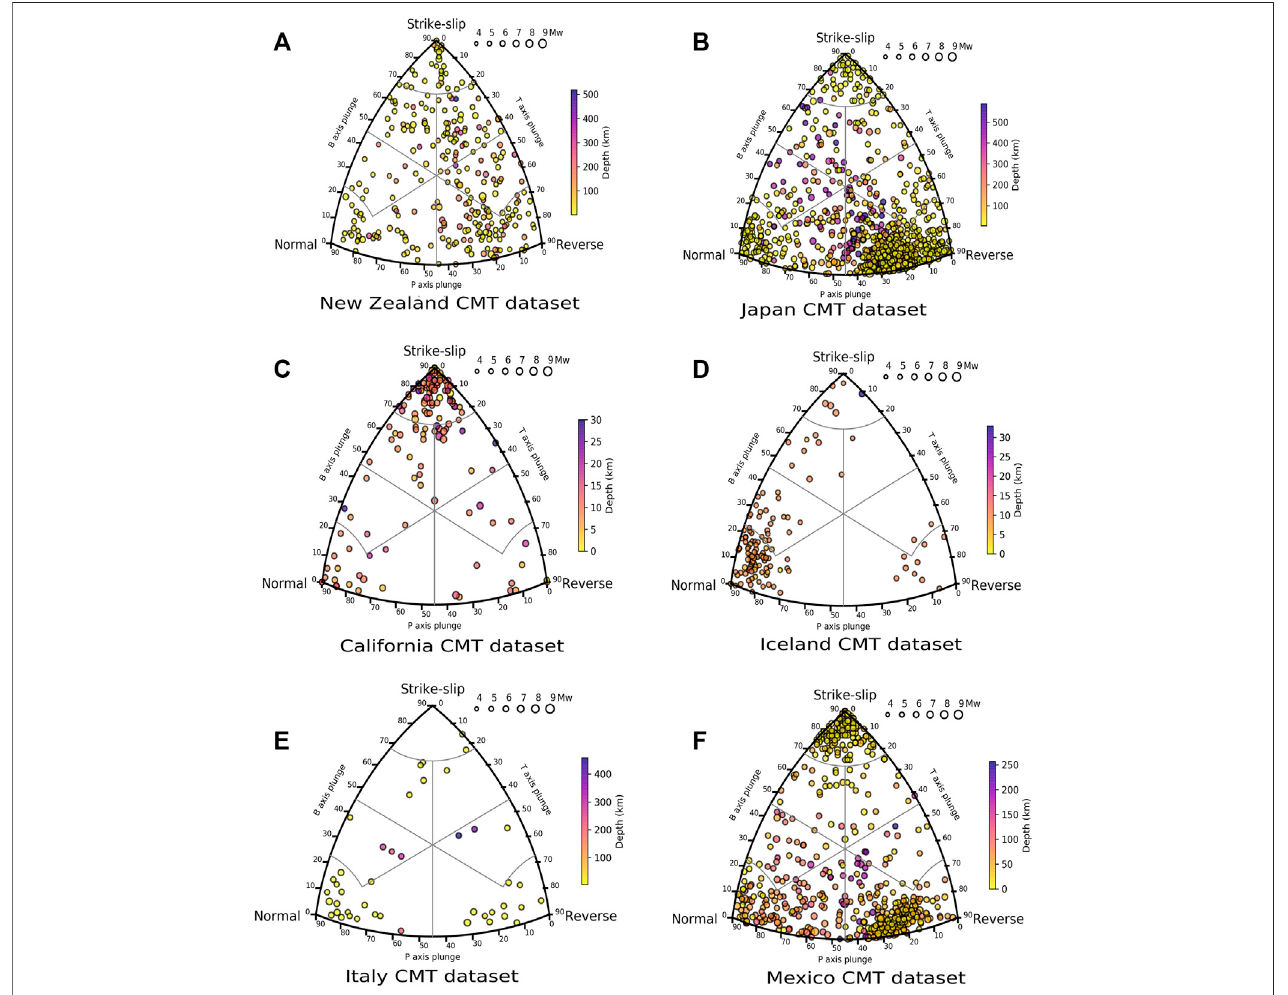
FIGURE3| Kaverina ’ sdiagramsforselectedsixregions: (A) NewZealand M ≥ 4.8, (B) Japan M ≥ 5.5, (C) California M ≥ 4.4, (D) Iceland M ≥ 4.6, (E) Italy M ≥ 4.6, and (F) Mexico M ≥ 5.5.